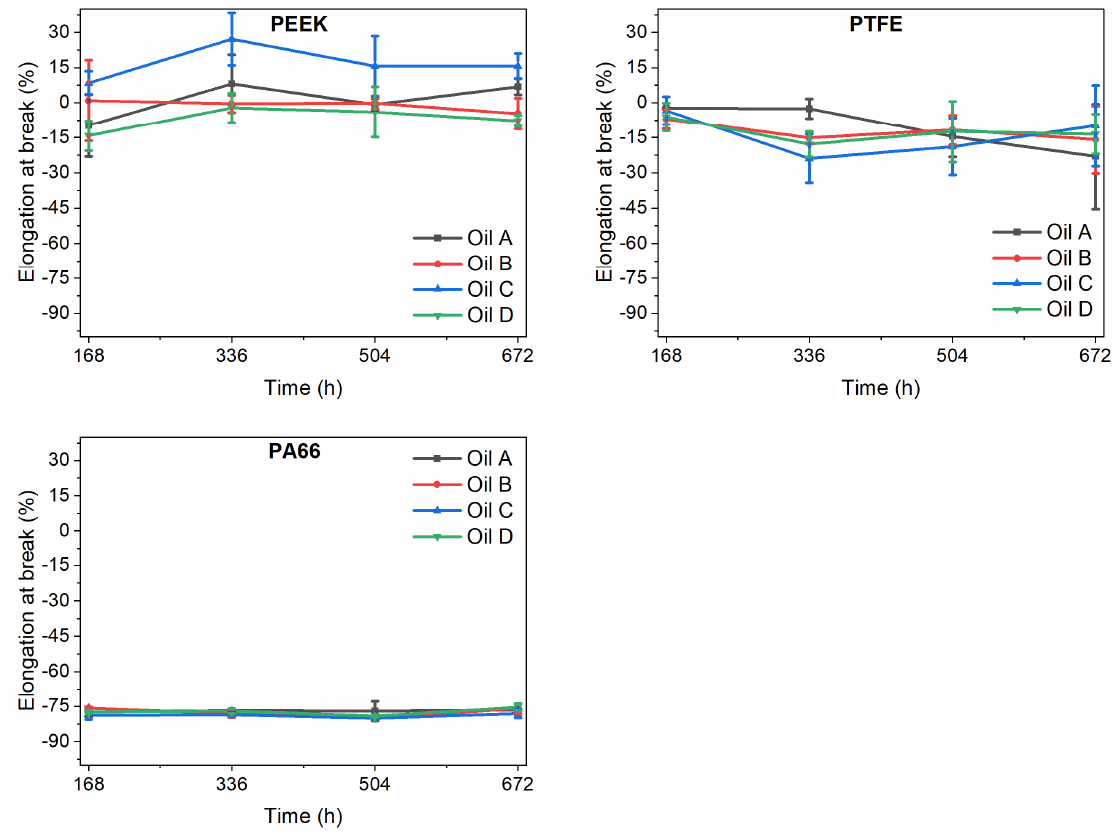
Figure 4. Changes in elongation at break of, PEEK, PA66, and PTFE after immersion in the ATFs.